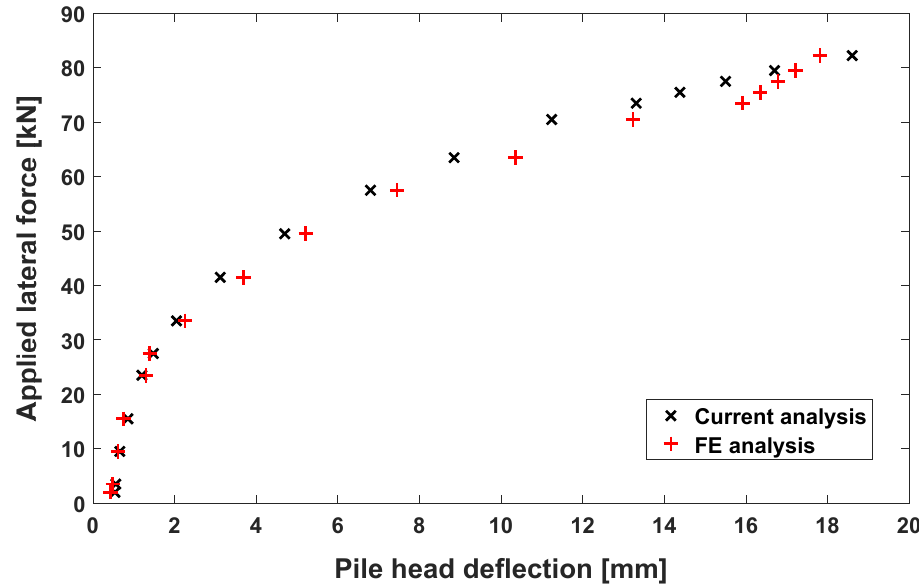
Figure 3. Comparison between the analytical and numerical lateral deflections of pile head versus applied lateral forces.